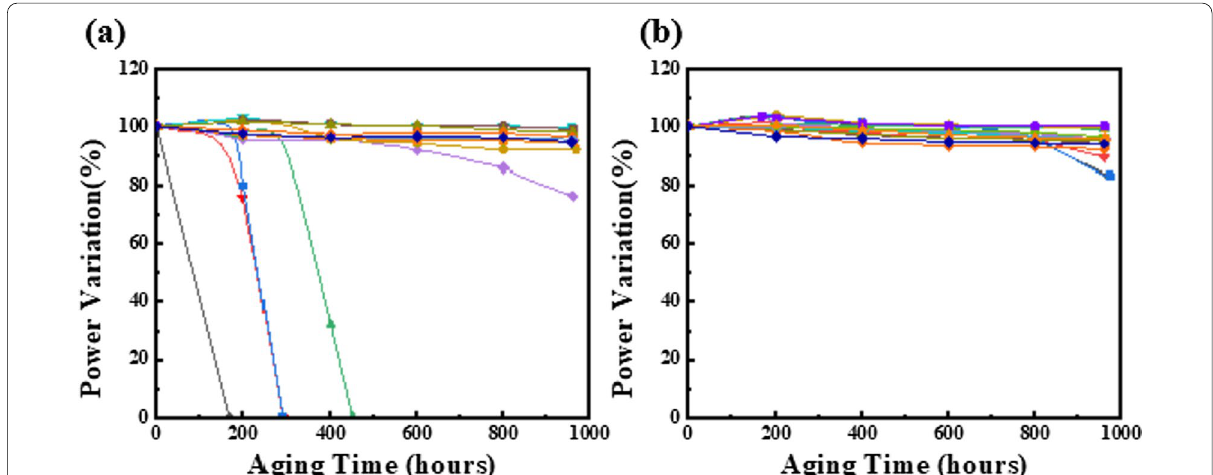
Fig. 11 WHTOL (85 °C/85% humidity) performance of VCSEL chips, a device A, only SiN x as passivation layer, b device B, Al 2 O 3 /SiN x as passivation